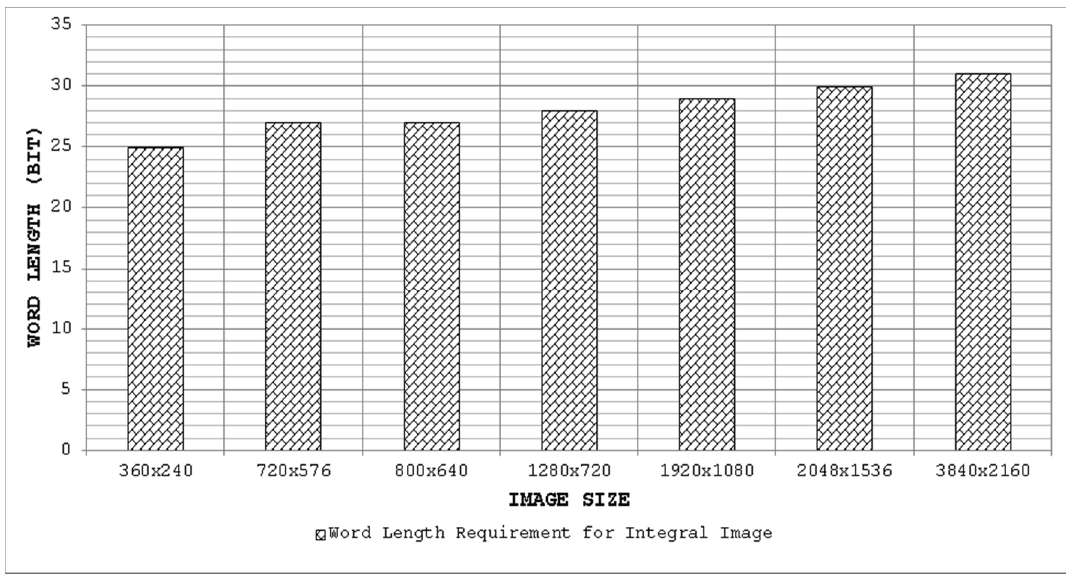
Figure 11. Word length requirements for integral image for some common image sizes considering 8-bit input